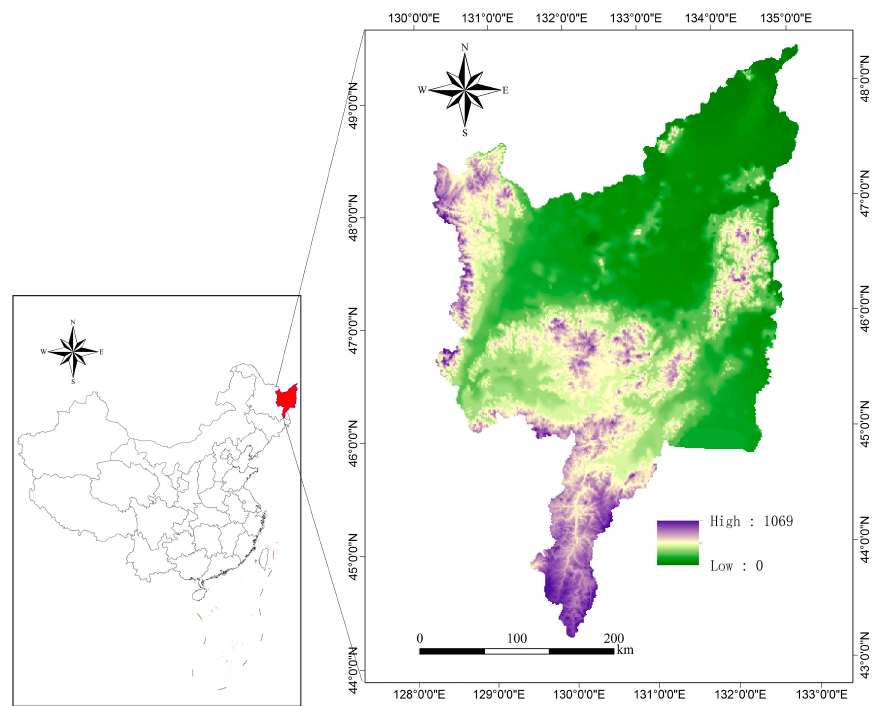
Figure 1. Geographical location and DEM (Digital Elevation Model) of the Sanjiang Plain in Northeast China.